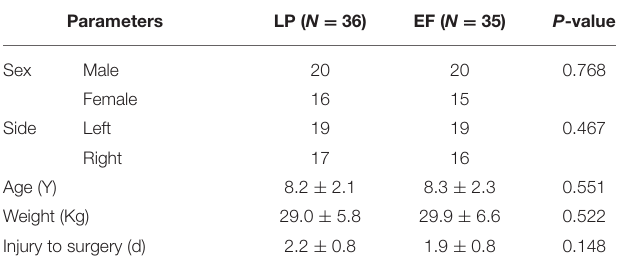
TABLE 1 | Patient demographic.